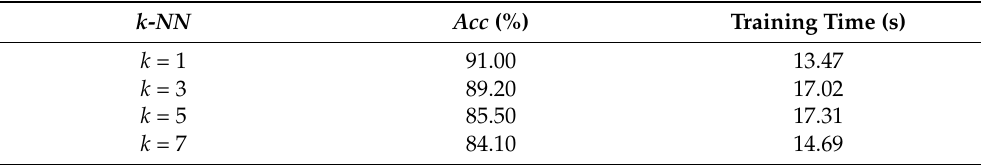
Table 1. The accuracy (%) results and training time (s) of the eyebrow images using SS + X with O = 0 and L = 2 with its respective value of k in the k-NN classifier.